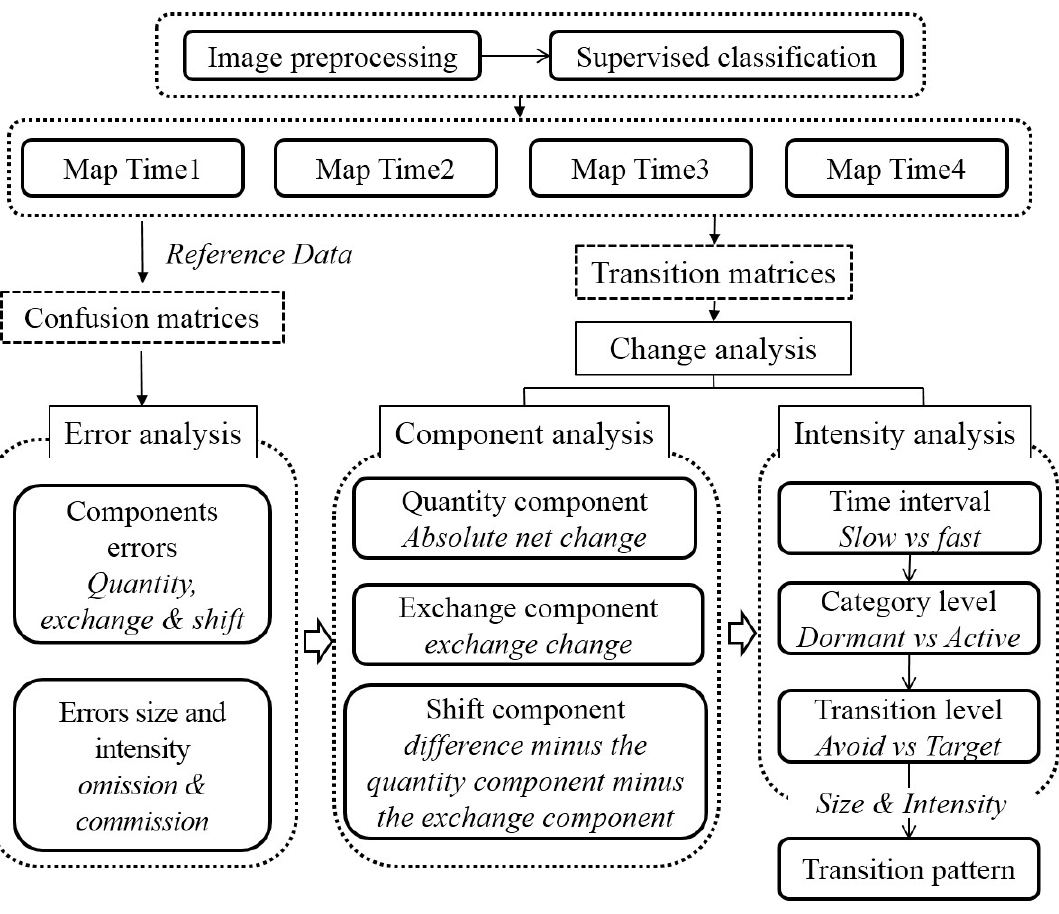
Figure 2. Framework for analyzing land change.